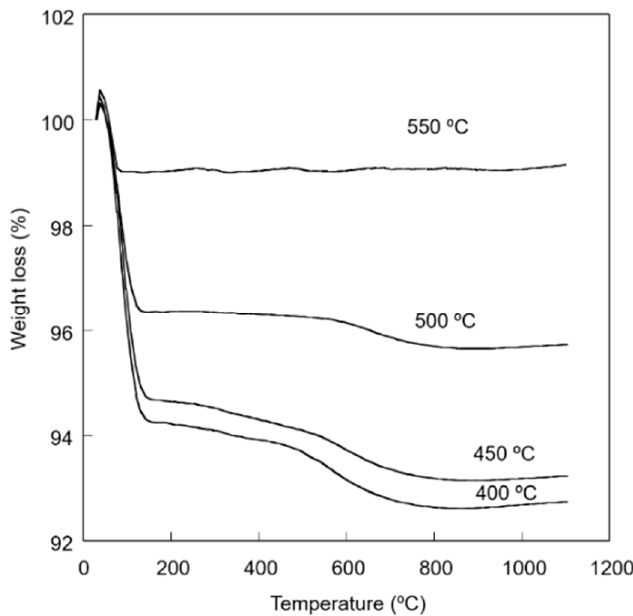
Figure 12. Thermogravimetric analysis (TGA) curves of the SiO 2 particles for a coating aged for 5 days and cured at 400, 450, 500 and 550 °C.